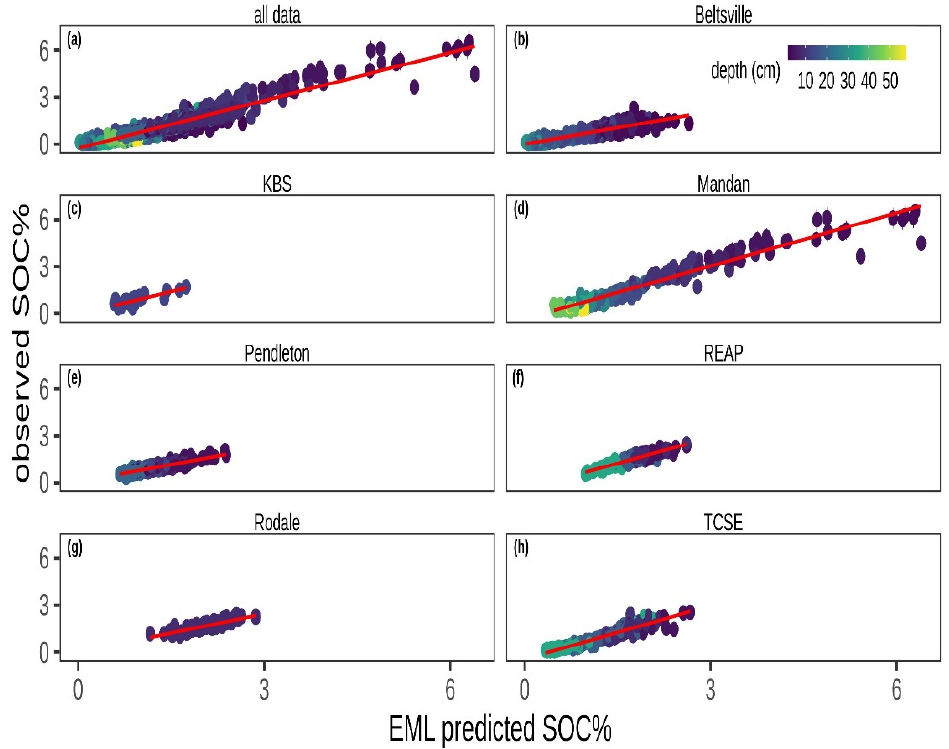
(Table S3) compared to corresponding observed measurements.